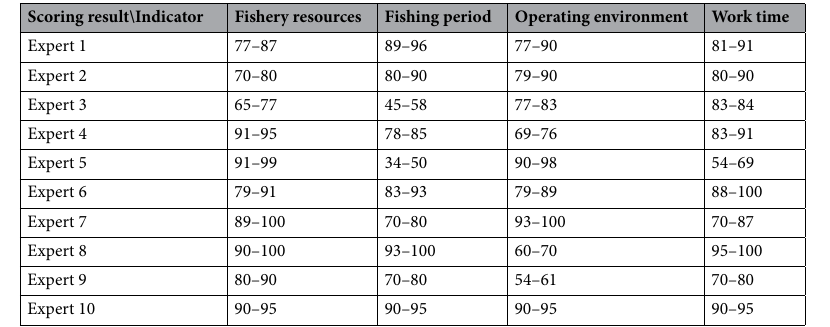
Table 13. Scoring result(Resources and distribution of fishing objects).